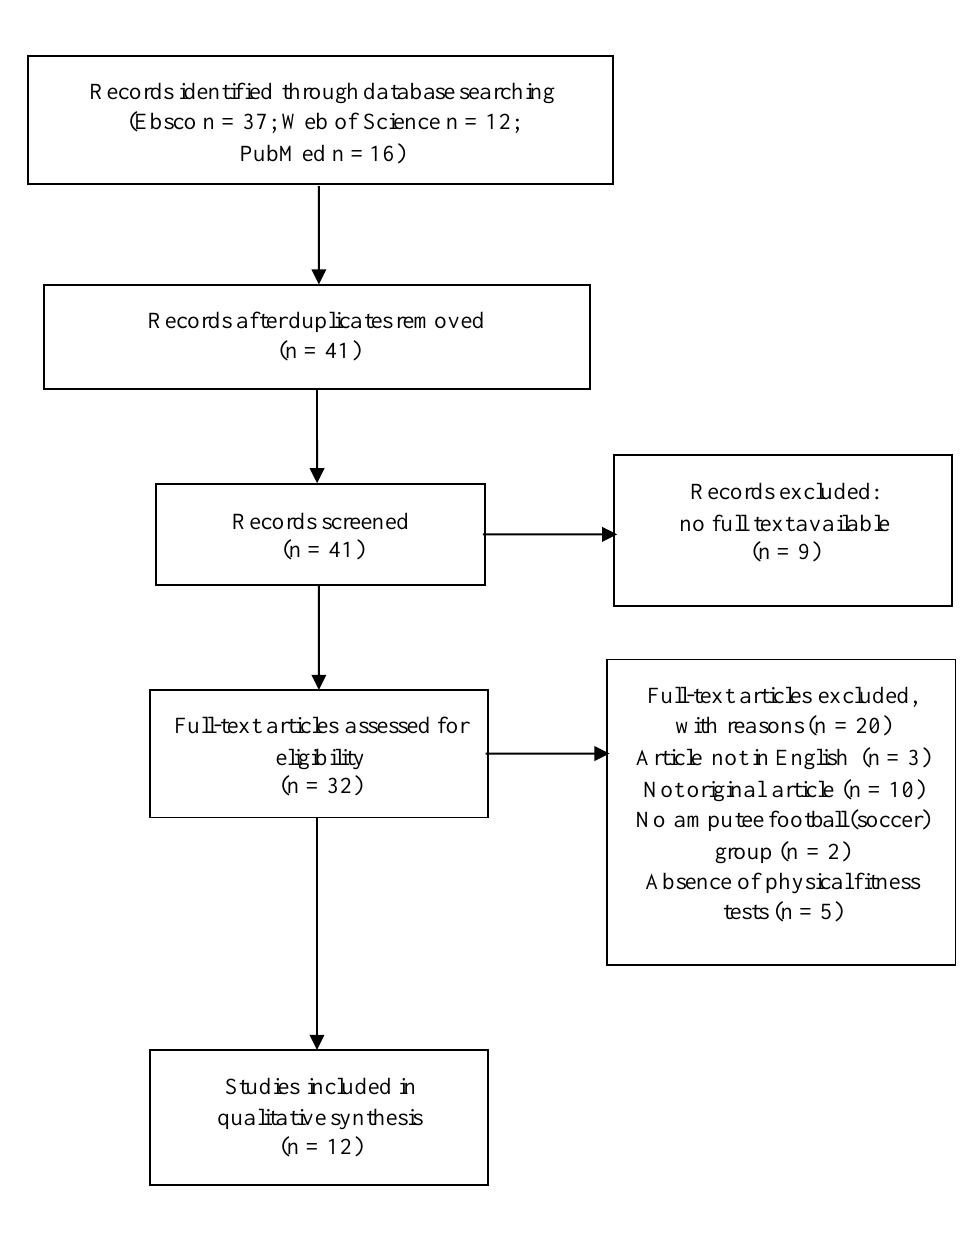
Figure 1. Study selection flow